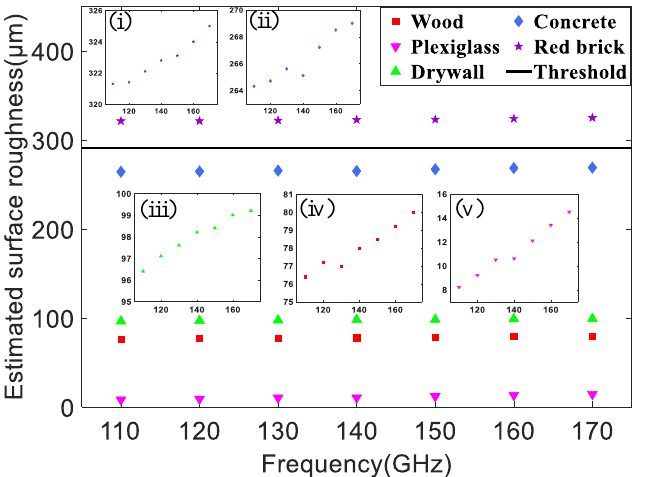
Figure 9. The relationship between estimated surface roughness of five materials and frequencies in